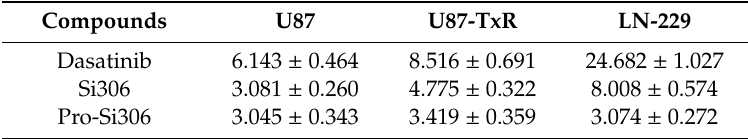
Table 1. Sensitivity of glioblastoma multiforme (GBM) cells to c-Src inhibitors expressed as half maximal inhibitory concentration (IC 50 ) values ± S.D. (µM), calculated from three independent experiments ( n = 3).